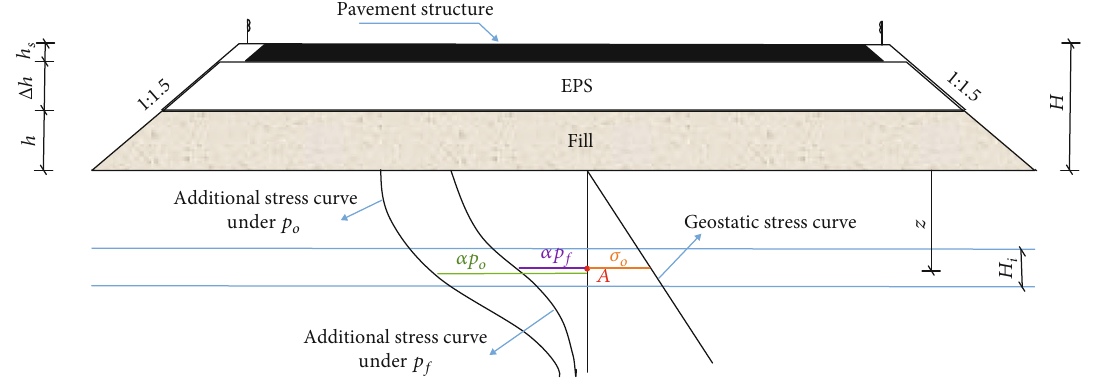
Figure 4: Cross-section of EPS fi